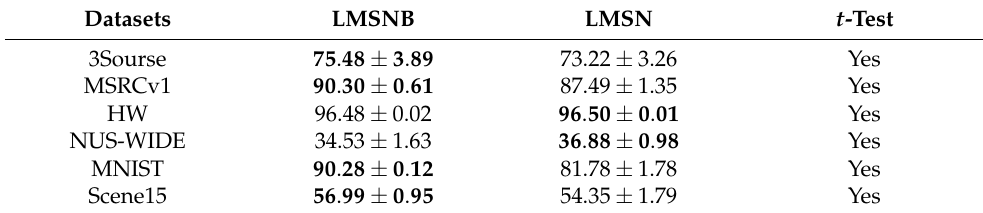
Table 4. The ACC performance of ablation study (mean ± standard deviation